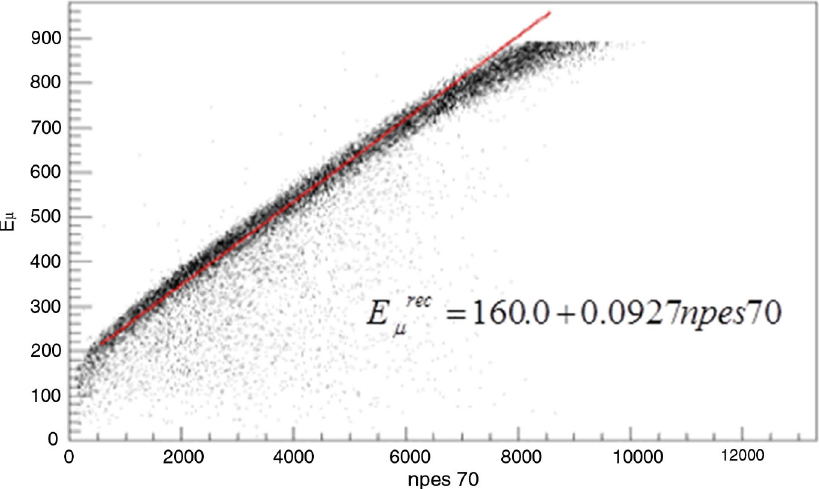
FIG. 23. Performance of the MEMPHYS detector. The reconstructed energy of a muon from a neutrino interaction is compared with the real energy, as a function of the number of photoelectrons detected.